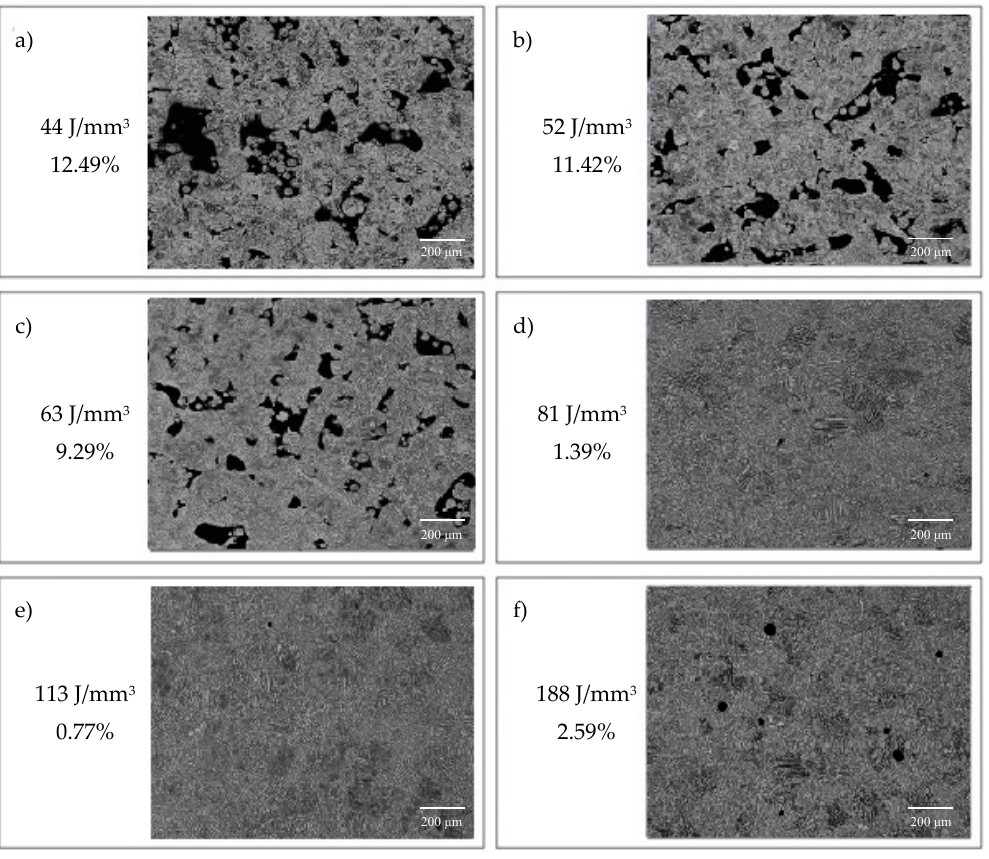
Figure 4. The influence of energy density on the porosity and their morphology: 44 J/mm 3 ( a ), 52 J/mm 3 ( b ), 63 J/mm 3 ( c ), 81 J/mm 3 ( d ), 113 J/mm 3 ( e ), 188 J/mm 3 ( f ), mag. 100×.